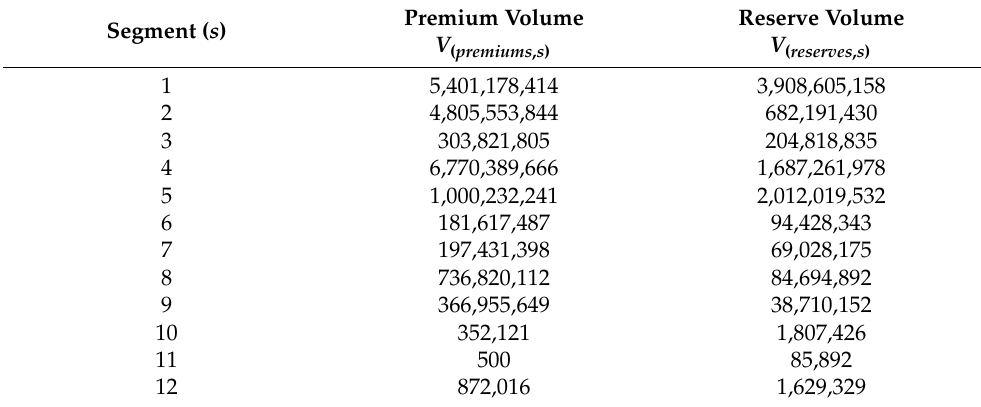
Table 3. Premium and reserve volume data.